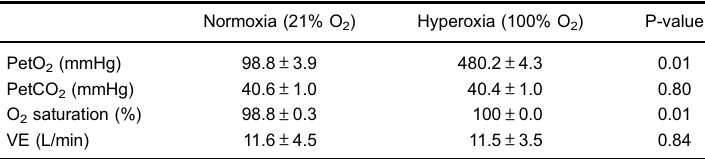
Table 1. Respiratory variables at normoxia and during hyperoxia.